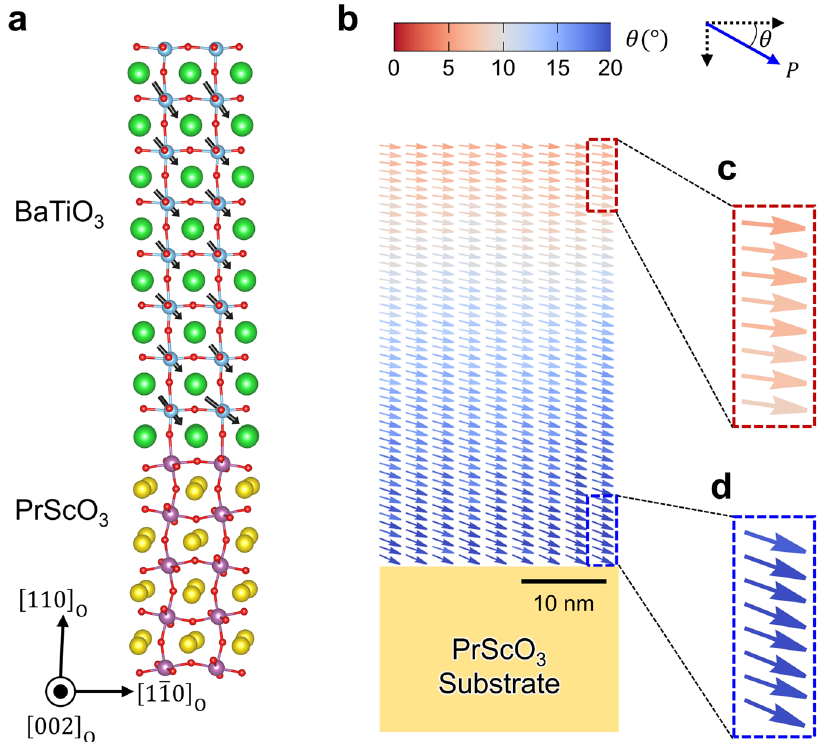
Fig. 2 Theoretical calculations of BTO/PSO heterostructure. a Calculated atomic structure of BTO/PSO ð 110 Þ O heterostructure. b The spatial polarization distribution of BTO fi lm obtained from the phase fi eld simulation. The fi lm was assumed to be 50 nm thick with a fully coherent interface with respect to (cid:1) (cid:3) the substrate. Color bar re fl ects the polarization angle with respect to PSO 1 (cid:1) 10 . c, d The out-of-plane polarization gradually decreases through the fi lm O thickness (from ( d ) to ( c )), becomes negligible near the fi lm surface, predicting single domain in-plane BTO fi